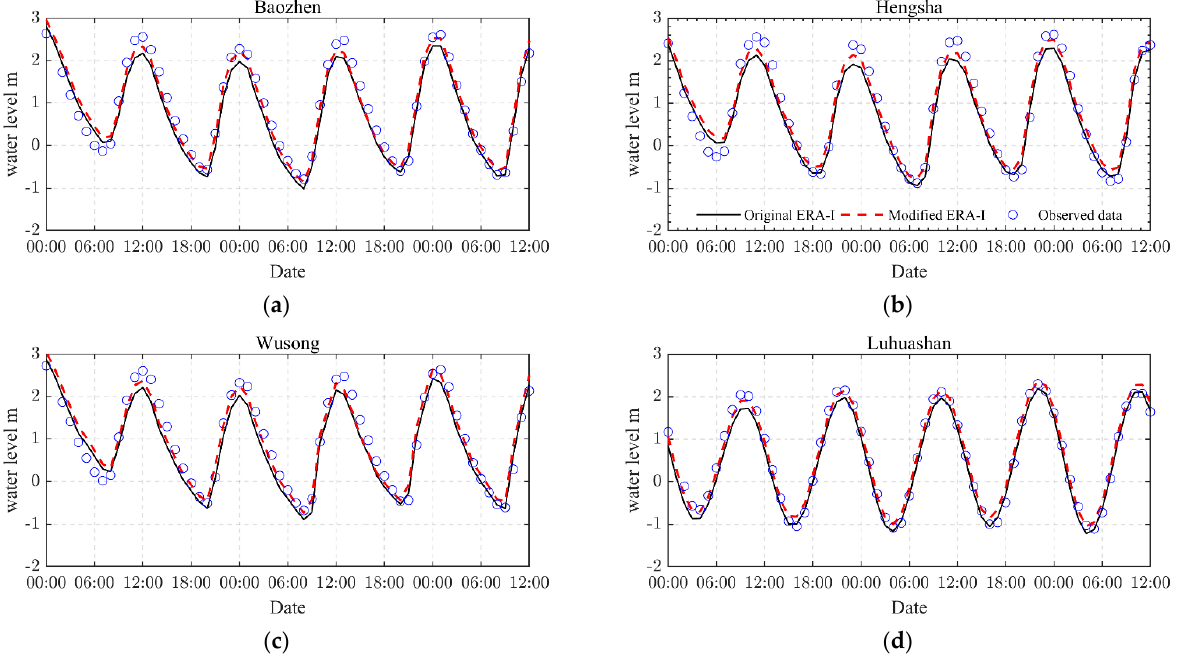
Figure 12. Water level comparison before and after correction at each station during Typhoon Phoenix in September. ( a ) Baozhen, ( b ) Hengsha, ( c ) Wusong, ( d ) Luhuashan. Table 4. Statistics of errors in measured and simulated water levels before and after application of the modified winds.